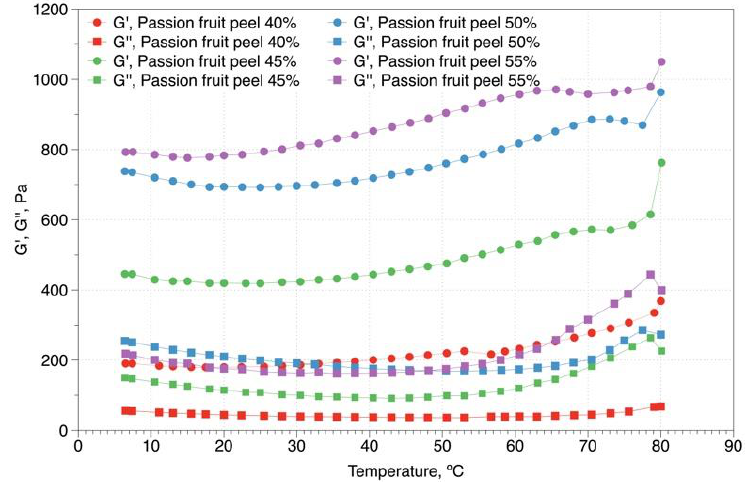
Figure 2. Temperature dependences of storage modulus (G ′ ) and loss modulus (G ″ ) for the passion fruit peel extract.